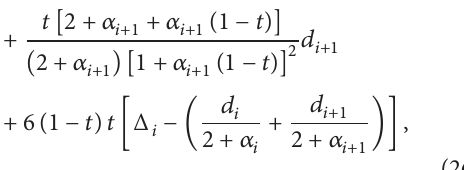
, 𝑥 ] . From (11), 𝑖 𝑖+1